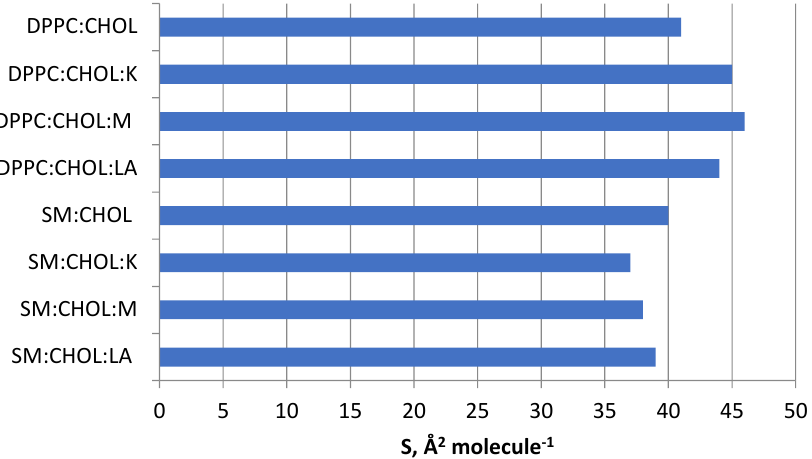
Figure 4. The specific surface of DPPC:CHOL, DPPC:CHOL:K, DPPC:CHOL:M, DPPC:CHOL:LA